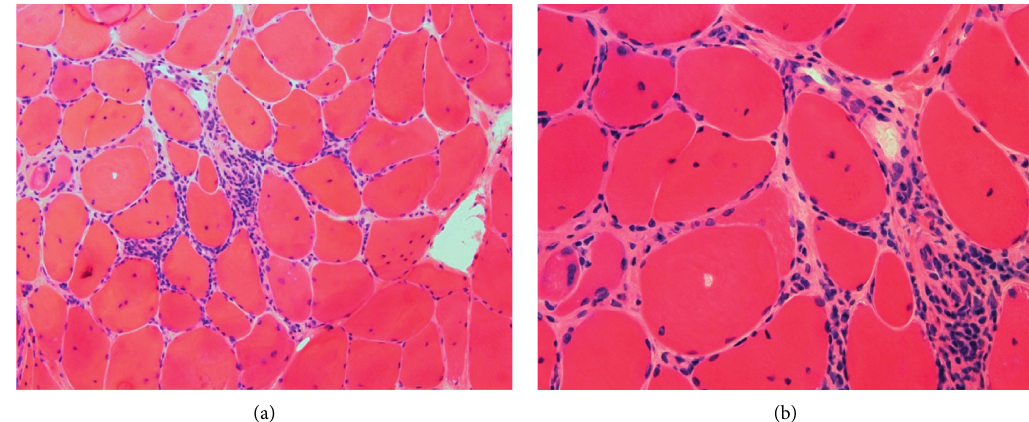
Figure 1: Histopathologic images of the muscle biopsy. Hematoxylin and eosin staining ((a), 10x power) is remarkable for the presence of numerous endomysial inflammatory cells, which lead to myophagocytosis, myofiber degeneration, and atrophy. (b) A higher power image (20x) and demonstrates numerous internalized nuclei which involve the majority of myofibers, and one myofiber with an intramyofibrillar vacuole. The inflammatory cells are predominately composed of CD3 and CD8 positive T-lymphocytes and CD68 positive macrophages (not